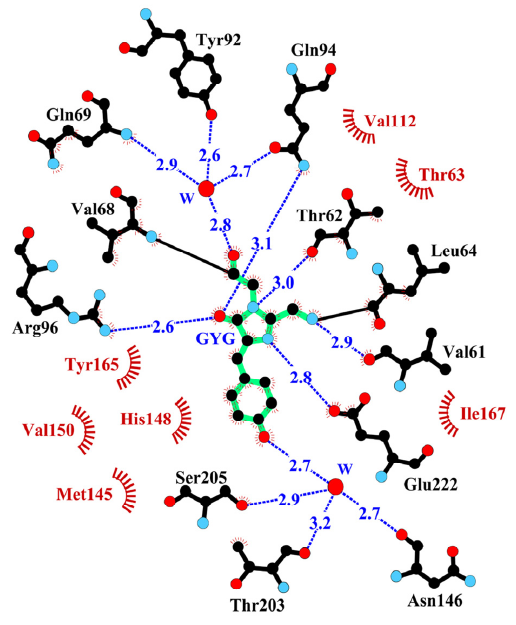
Figure 2. The nearest amino acid environment of the chromophore (shown in green) in the BrUSLEE structure within 4 Å. Hydrogen bonds ( ≤ 3.3 Å) are shown as blue dashed lines, water molecules (W) as red spheres, and van der Waals contacts as orange “eyelashes” (figure prepared with LIGPLOT/HBPLUS [11]).